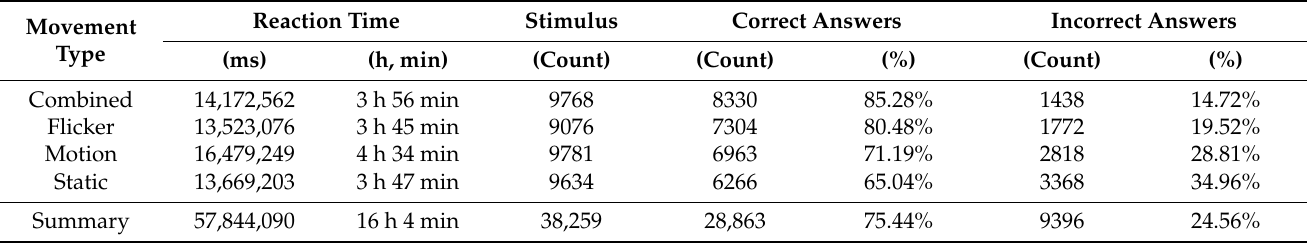
Table 4. Summarized data from the experimental results according to the type of movement.